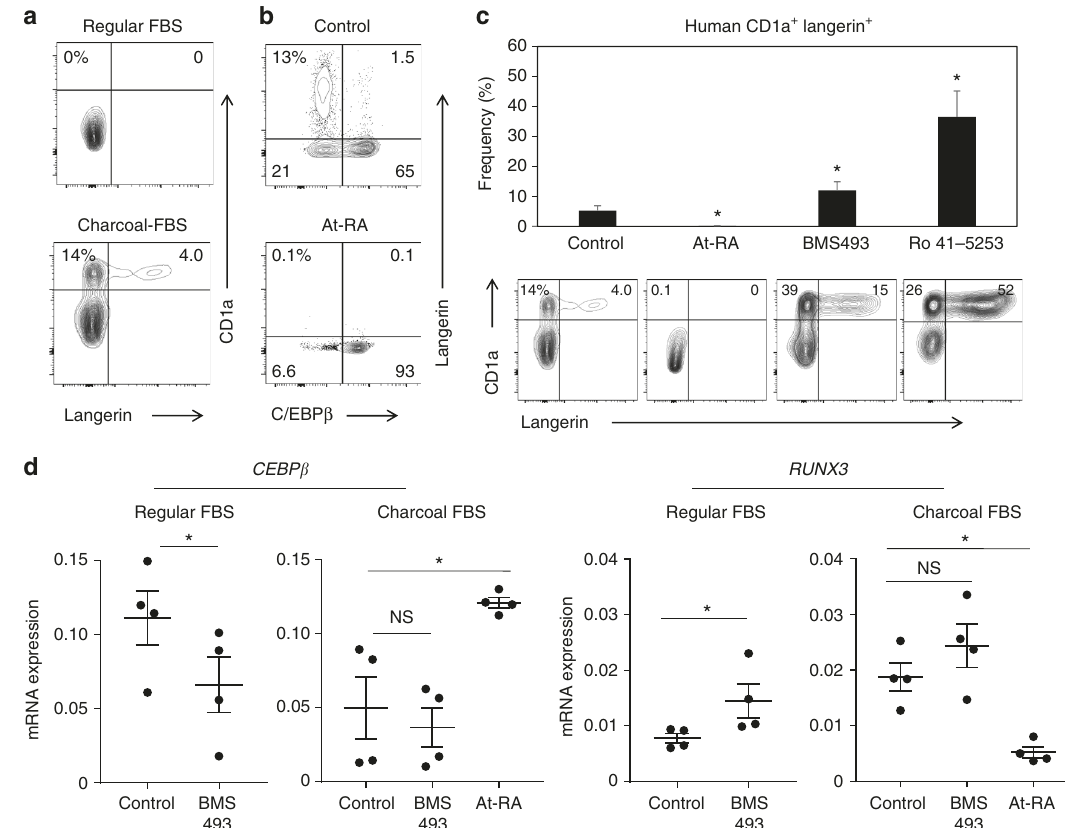
Fig. 7 RA regulates CEBPb and RUNX3 expression and human langerin + cell differentiation from blood monocytes. a Human LC differentiation from blood monocytes in regular vs. charcoal FBS. b At-RA promotes C/EBP β + non-LC differentiation. c RA and RAR α antagonists reciprocally regulate human LC differentiation. d Effects of At-RA and BMS493 on the expression of human CEBPb and RUNX3 . Human blood CD14 + monocytes were cultured in GM-CSF and TGF- β 1 for 5 – 7 days in media containing charcoal FBS except in panel A where regular FBS was also used. At-RA was used at 1 nM, and BMS493 and Ro4153 were used at 500 nM. Representative and combined data ( n = 5 – 7) from at least 5 experiments are shown. *Signi fi cant differences from control by Mann – Whitney U test ( p < 0.05, unpaired, 2-sided). Error bars are de fi ned as s.e.m. Langerhans cells (LC) and langerin-expressing conventional dendritic cells are made from distinct progenitors and enriched in the distinct microenvironments of the skin. Here the authors show that these immune cells are regulated by RAR α via simultaneous induction of LC-promoting Runx3 and repression of LC-inhibiting C/EBP